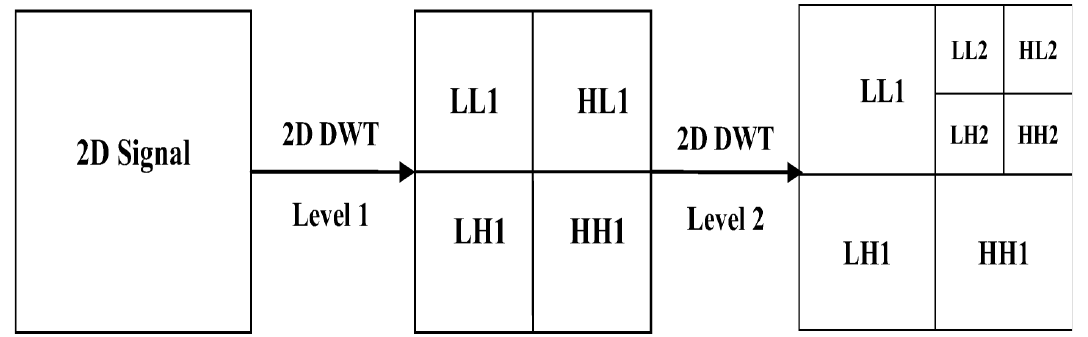
Figure 6. The synthesis process of 2D ‐ DWT ‐ 2L. Decomposition of signals into their high ‐ and low ‐ frequency approximations is there ‐ fore a straightforward process. LL, LH, HL, and HH represent the average horizontal and vertical information of the visual signals at Level 1 detail. Each of the four sub bands at level 2 is further subdivided.